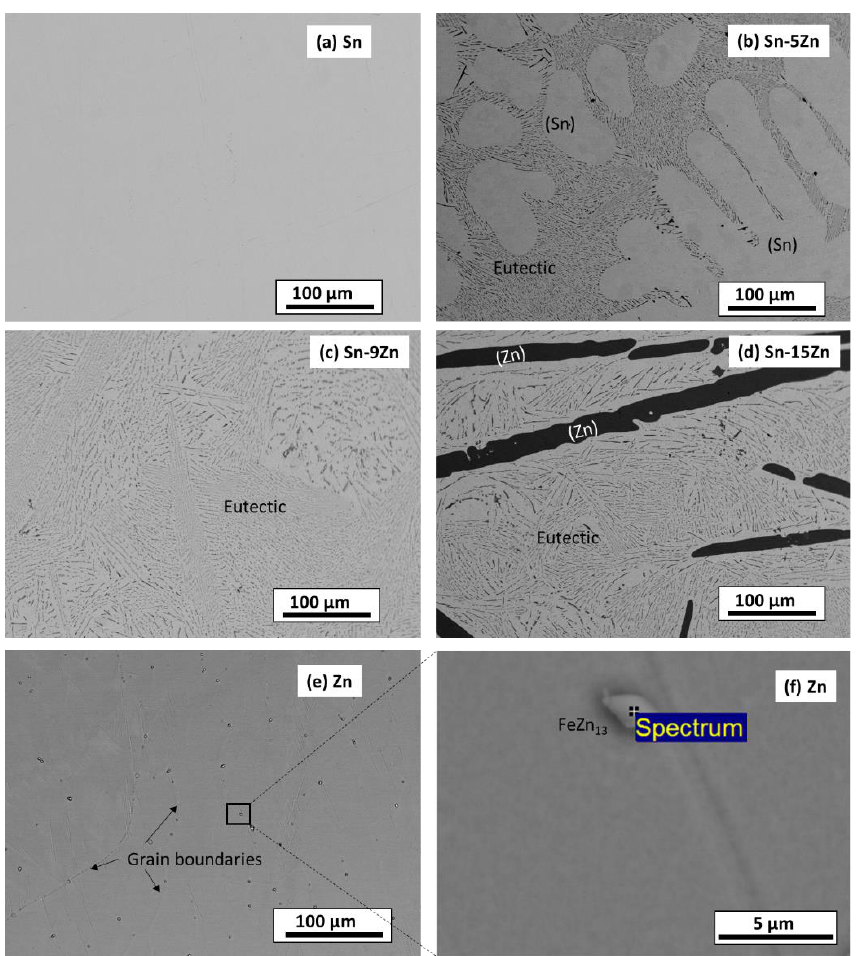
Figure 1. Room-temperature XRD patterns of as-cast Sn – Zn alloys.